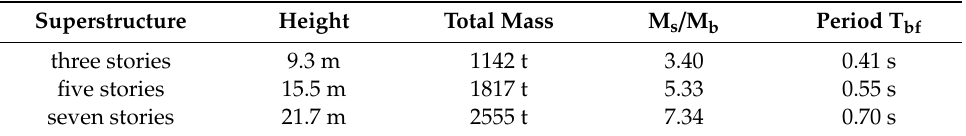
Table 2. Main properties of the three structural model in fixed-base